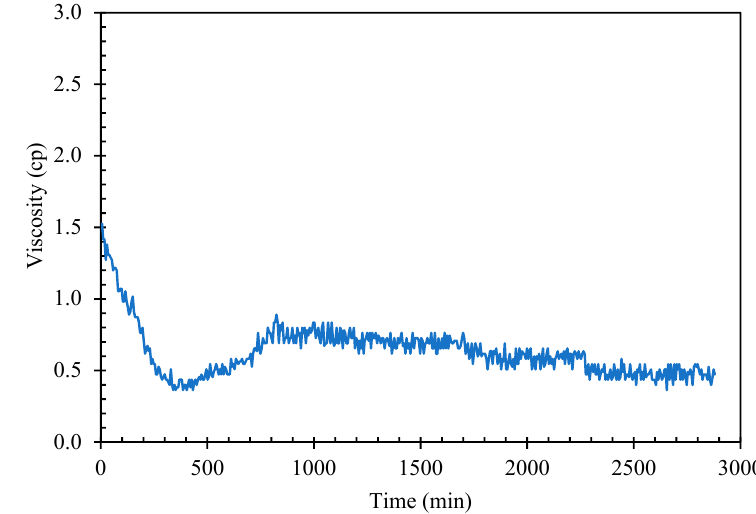
Figure 4. CP–Water mixture viscosity without hydrate seeds/flakes addition.